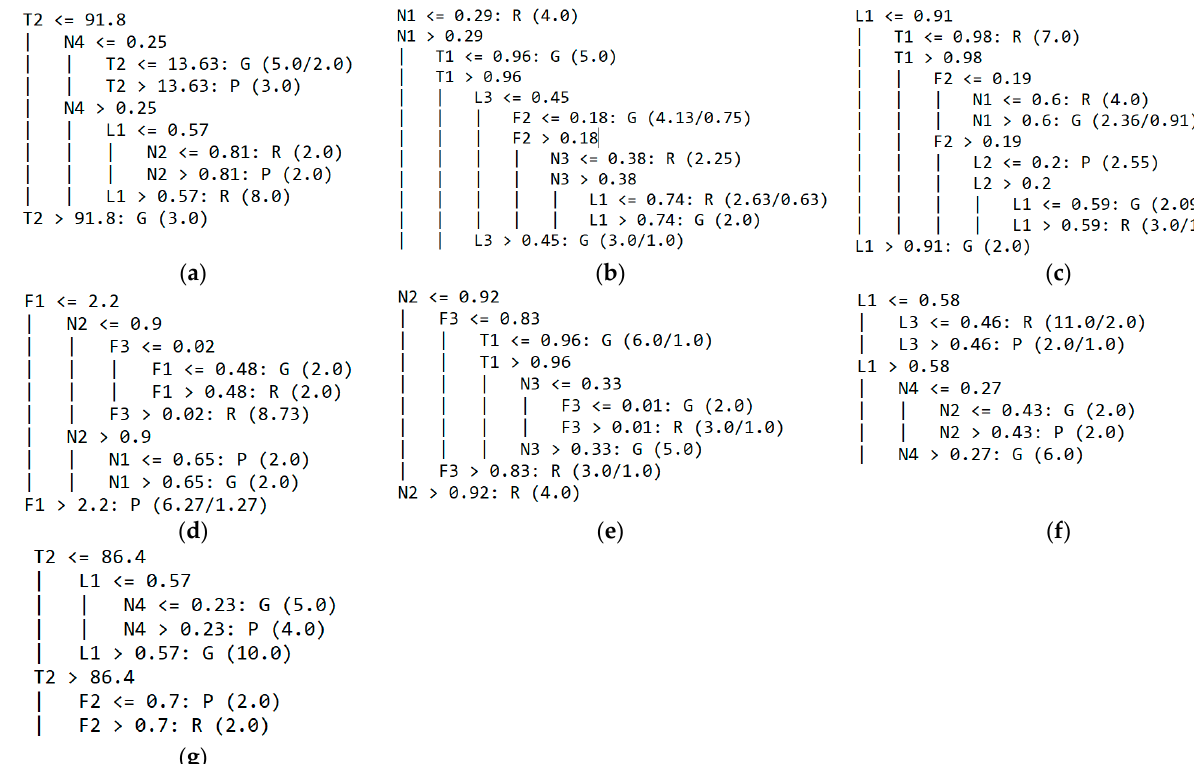
Figure 4. Decision trees for the classifiers. ( a ) MLP, ( b ) Naïve Bayes, ( c ) 3-NN, ( d ) C4.5, ( e ) Logistic, ( f ) Deep Learning and ( g ) SVM.